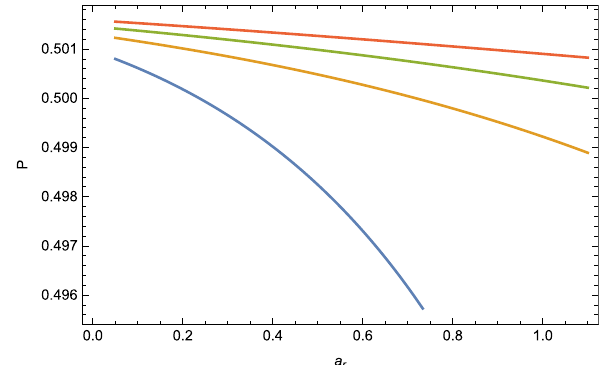
Fig. 6 Case 3. For varying j c values, the surface potential p is a func- tionofthepolytropicindex a r . j c = 0 . 10 (blueline), j c = 0 . 18(orange line), j c = 0 . 24 (green line), j c = 0 . 30 (red line)